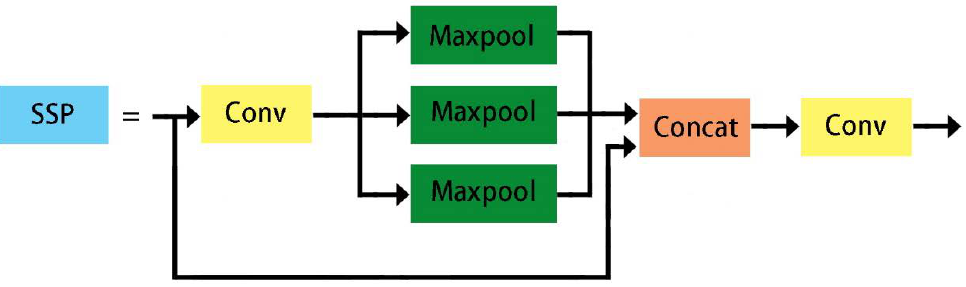
Figure 8. The structure of the SSP module.